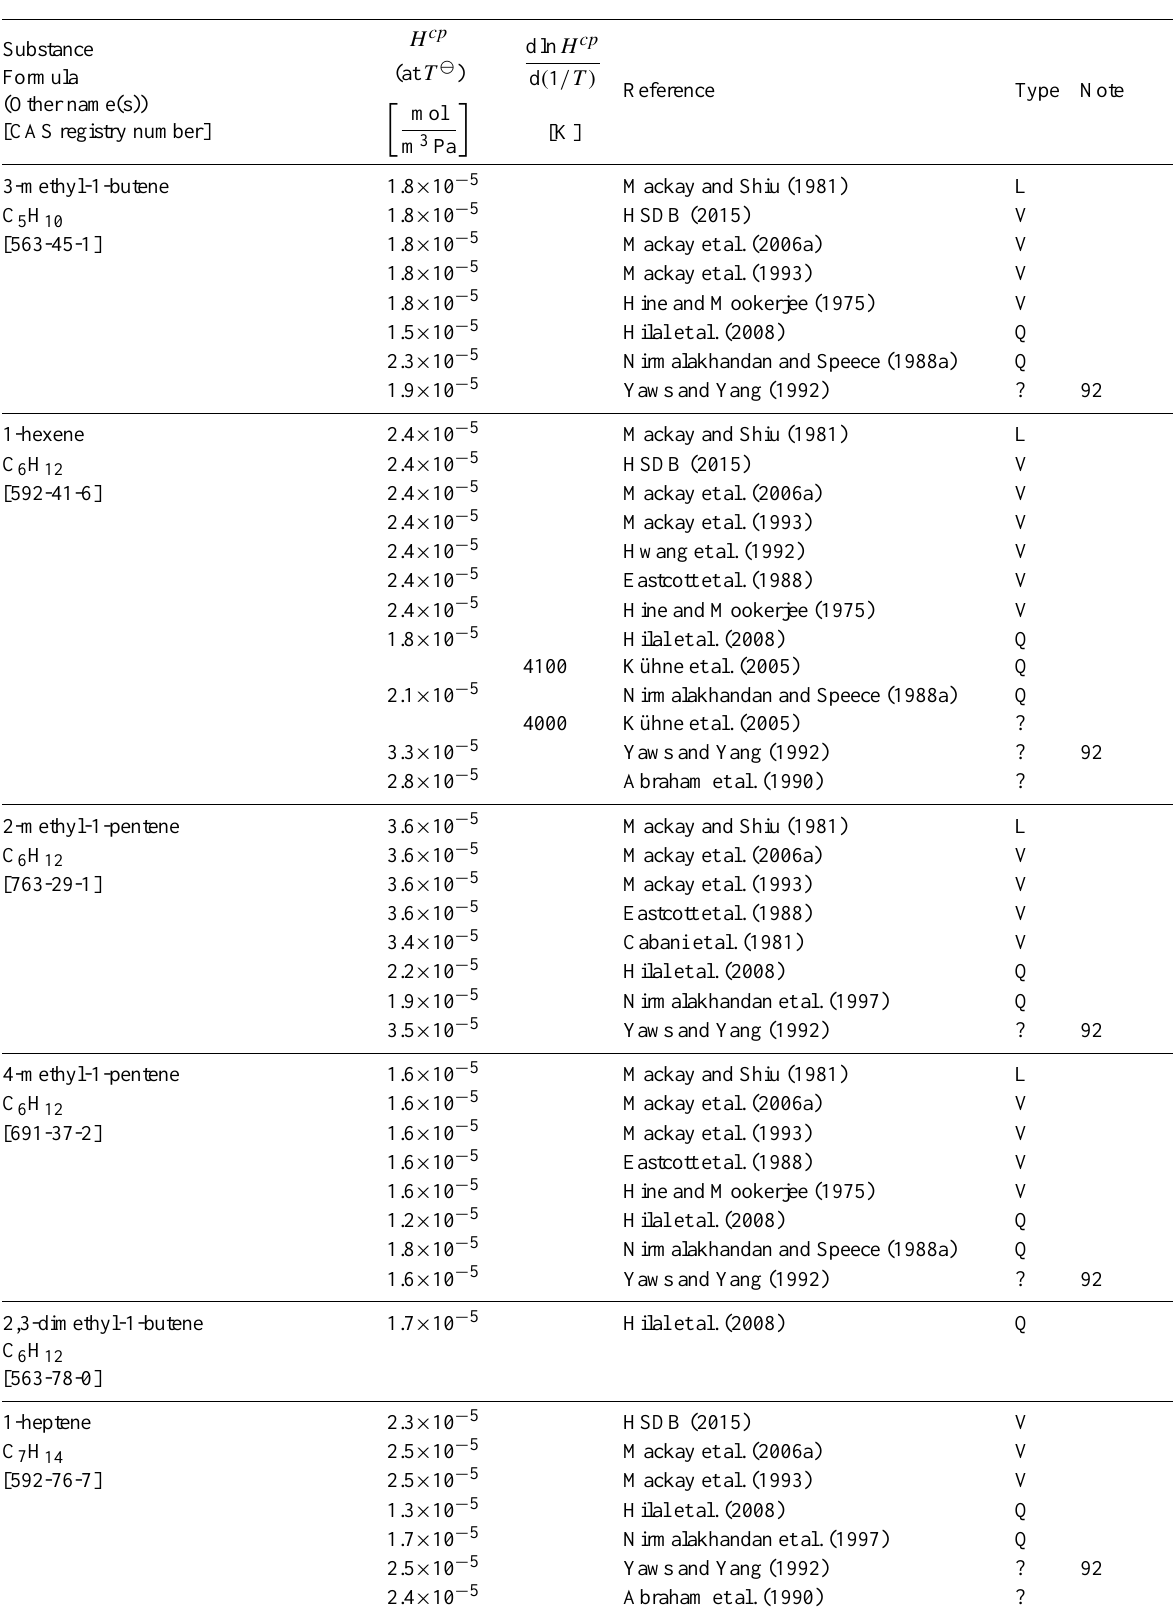
Table 6: Henry’s law constants for water as solvent